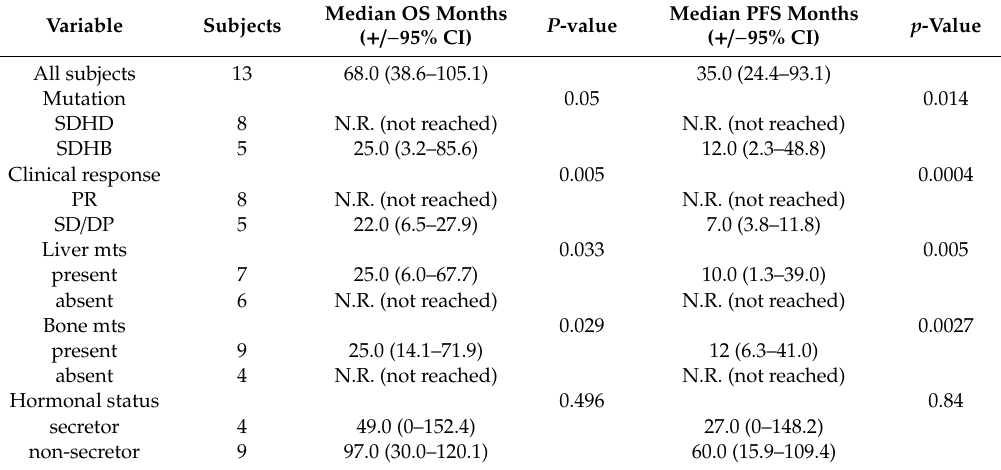
Table 5. Median overall survival (OS) and progression-free survival (PFS) for the overall group of patients with SDHx mutation including both subgroups SDHD and SDHB, hormonal status in entry into the study, presence of liver and bone involvement and also clinical response evaluated six weeks after PRRT as partial response (PR), stable disease (SD) or disease progression (PD). Abbreviation: N.R. not reached.